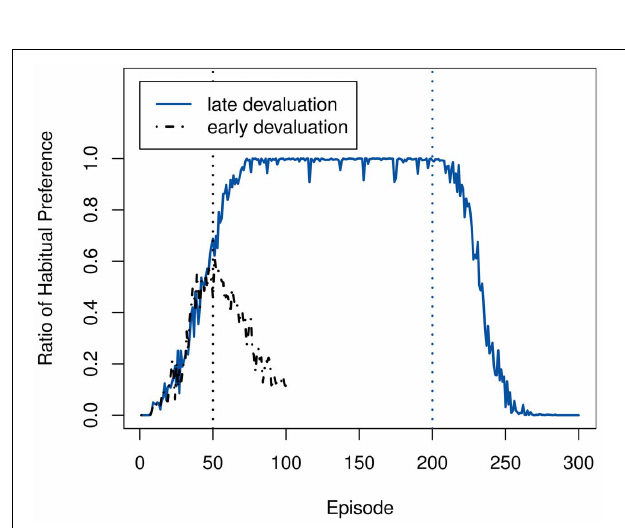
FIGURE 7 | Ratio of how often the habitual system is selected vs. the goal-directed one, when using both intrinsic and extrinsic rewards. The vertical lines mark the times of devaluation at 50 and 200